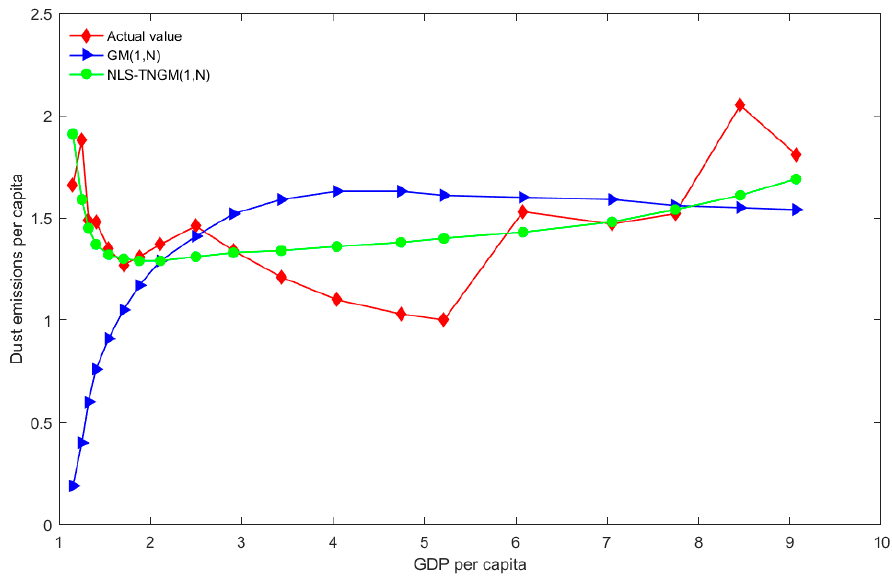
Figure 4. The distributions of forecasted values of dust emissions per capita using the two models, and actual values.